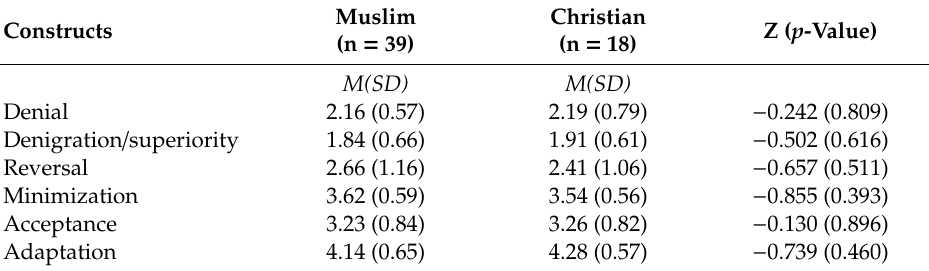
Table 6. Religious-related di ff erences of IRSSQ